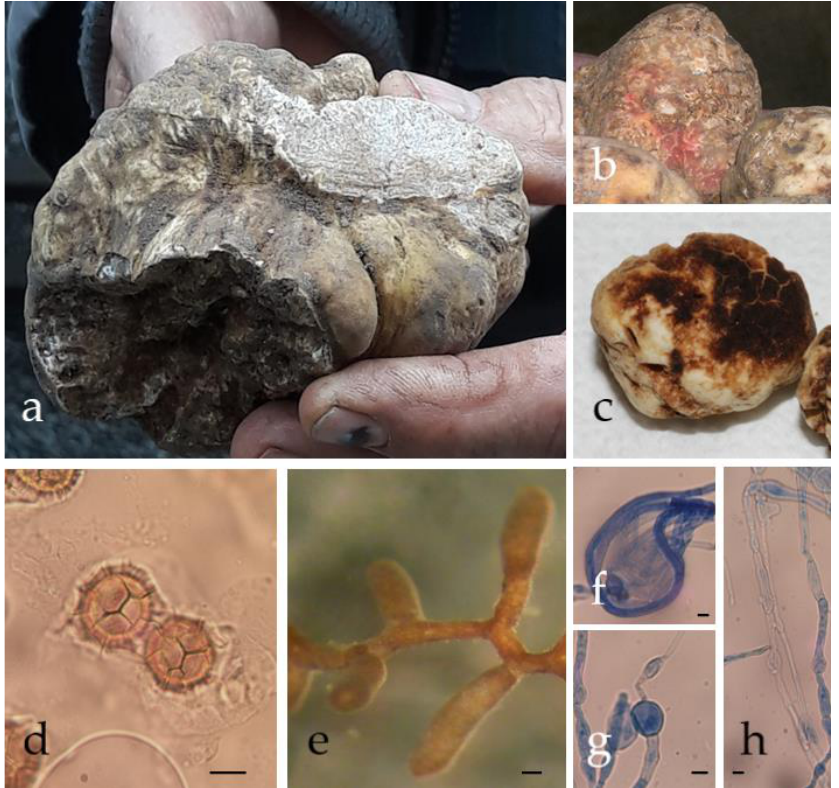
Figure 1. Morphology of T. magnatum ascomata ( a – c ), spores (bar = 10 µm) ( d ), mycorrhizas (bar = 100 µm) ( e ) and mycelium-colored with blue cotton (bar = 10 µm) ( f – h ). ( a ) T. magnatum broken ascoma, ( b ) reddish patches, ( c ) brown spots, ( d ) reticulated spores, ( e ) T. magnatum mycorrhizas, ( f ) hyphal aggregates, ( g ) vesicles and ( h ) anastomosis.